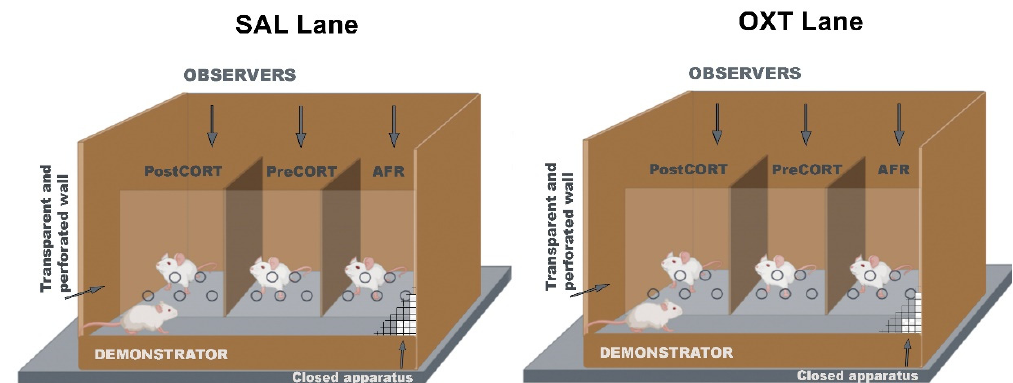
Figure 19. Emotional Contagion assay setting. Observers’ side and Demonstrator’s side were divided by a transparent and perforated Plexiglas ® partition, while the Observers’ side itself was divided into three equal sectors by opaque walls [48].